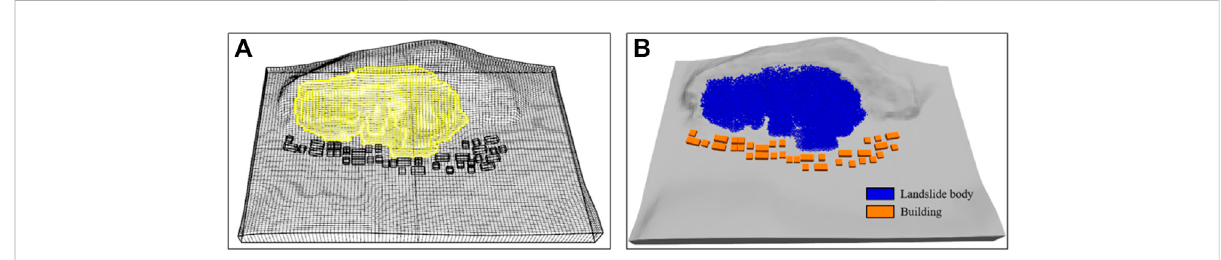
FIGURE 6 Landslide model produced from PFC 3D : (A) grid model; (B) geometric model.